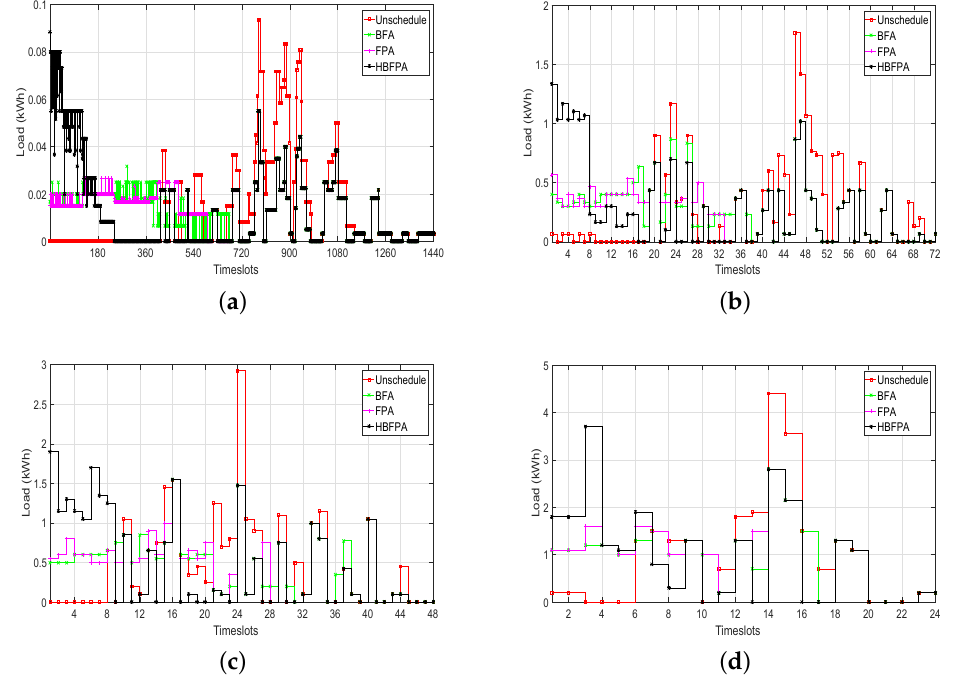
Figure 4. Load for single home using critical peak pricing. ( a ) load using operational time interval of 1 min; ( b ) load using operational time interval of 20 min; ( c ) load using operational time interval of 30 min; ( d ) load using operational time interval of 60